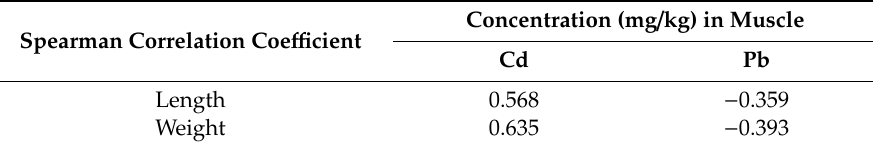
Table 5. Spearman correlation coe ffi cient for Cd and Pb according to length and weight. Spearman Correlation Coe ffi